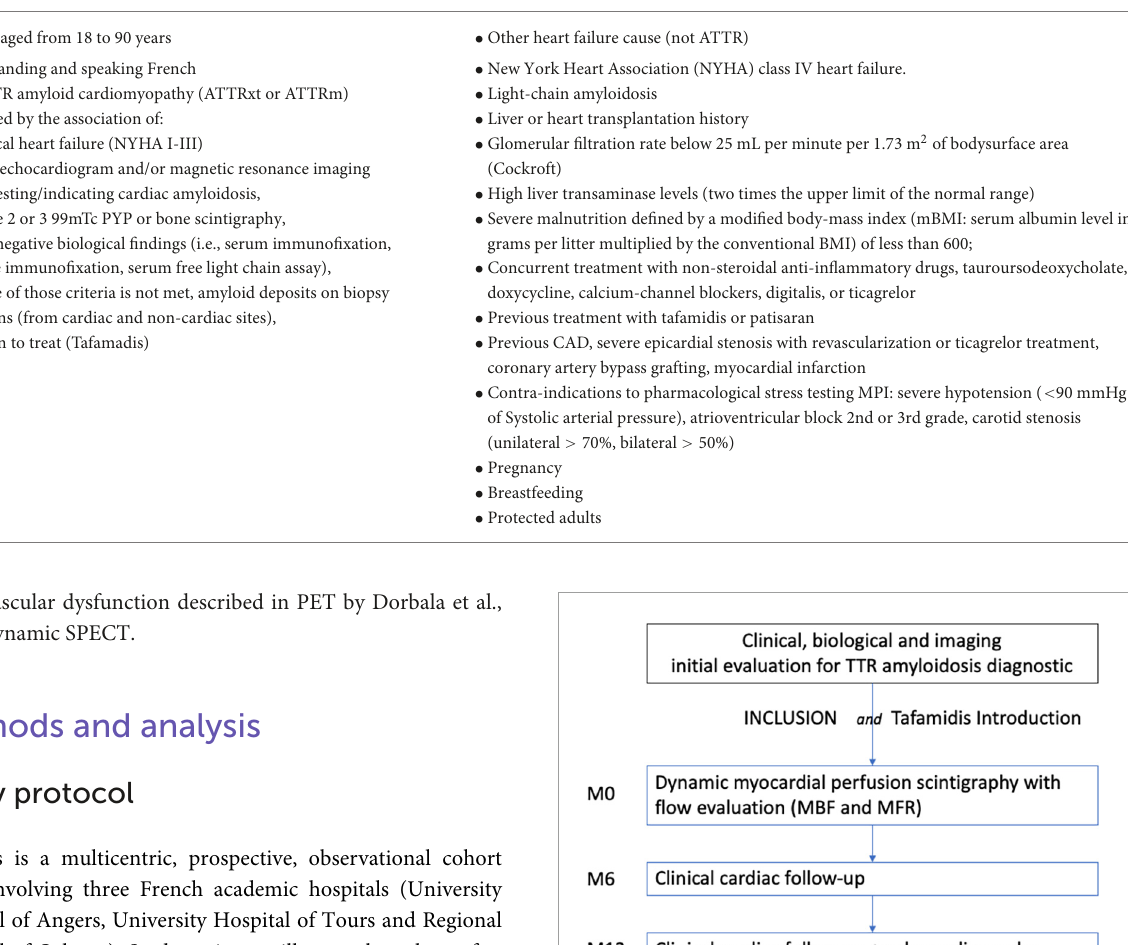
TABLE 1 Inclusion and exclusion criteria.